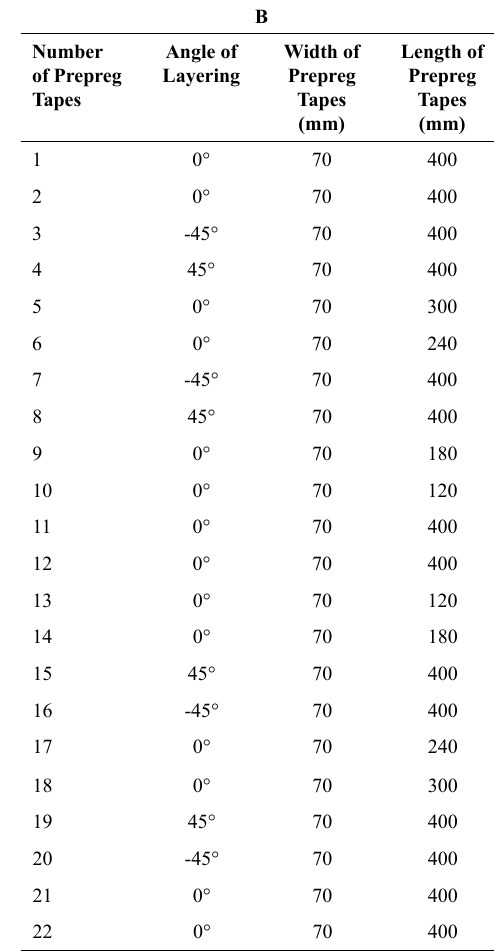
Table 1. Prepreg Cutting Size of Laminates. A Sizes of Laminates A1 and A2 with Equal thickness, B Sizes of Laminates B1 and B2 with Variable thickness